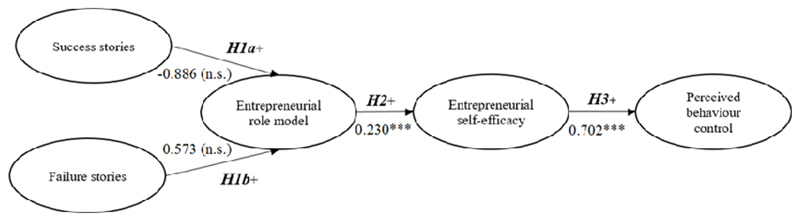
Research model results with unstandardised coefficients BSignificance code: ***p < 0.01.